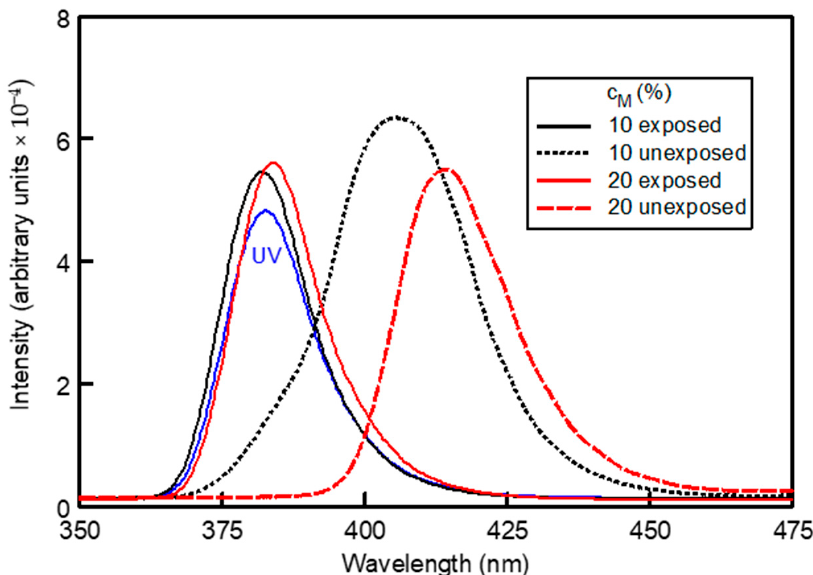
Figure 3. UV excited spectra for 10% and 20% doped DEH PE films in the unexposed and fully exposed states. The UV LED emission is included for reference.